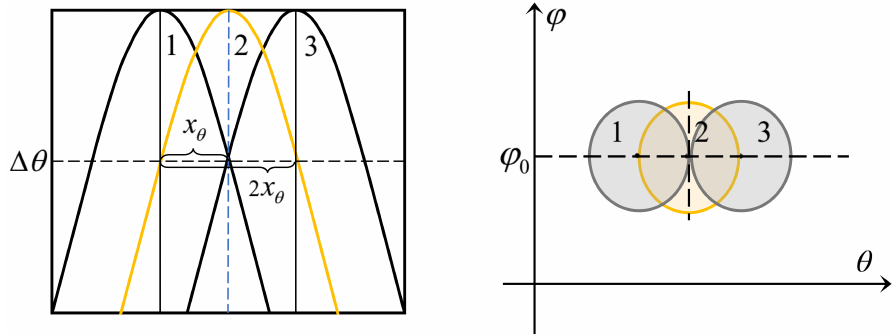
Figure 6. Beam tangent illustration of TAA in θ − ϕ